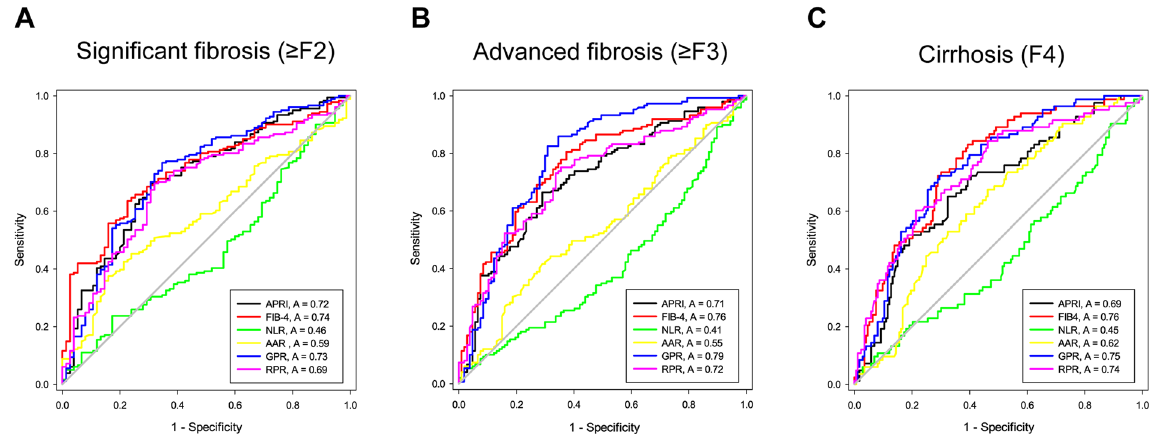
Figure 2. Receiver operating characteristic (ROC) curves of APRI, FIB-4, NLR, AAR, RPR and GPR in the prediction of significant liver fibrosis ( A ), advanced liver fibrosis ( B ) and liver cirrhosis ( C ) for the entire CHB